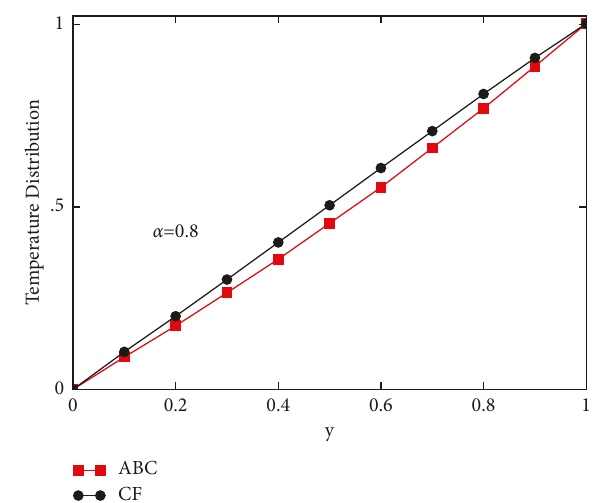
Figure 3: Correlation between the temperatures through CF [37] and present, Pr